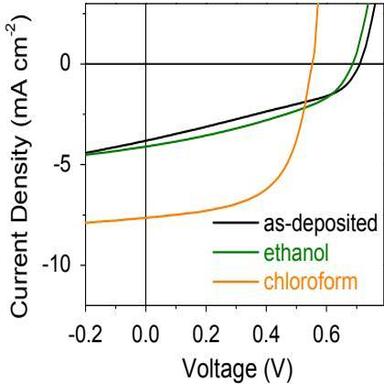
J-V characteristics (AM 1.5, 100 mW cm−2) of as-deposited and solventannealed P3HT:PC71BM organic photovoltaic devices.